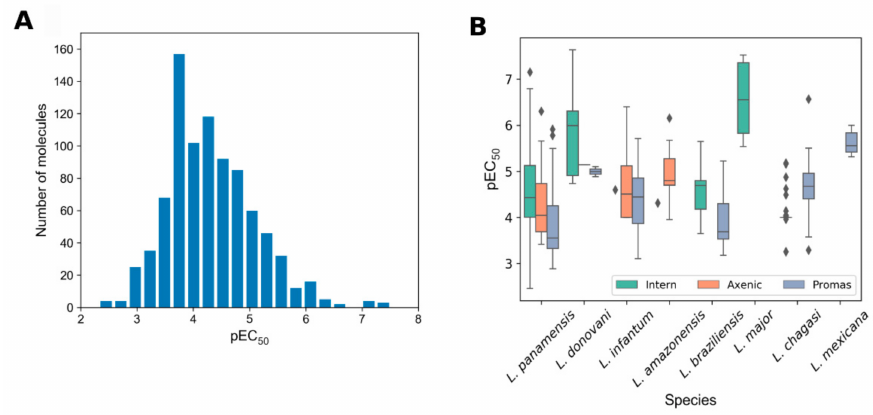
Figure 6. Antileishmanial activity of pure compounds expressed as pEC 50 . ( A ) Number of compounds associated with activity ranges and ( B ) distribution of activity according to parasite species and